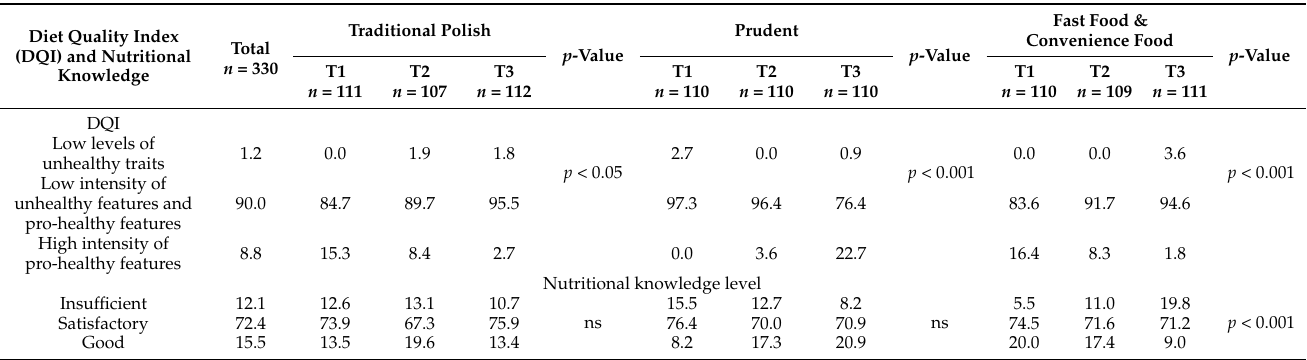
Table 4. Diet Quality Index (DQI) and nutritional knowledge (%) by adherence to the dietary patterns in the study sample ( n = 330).